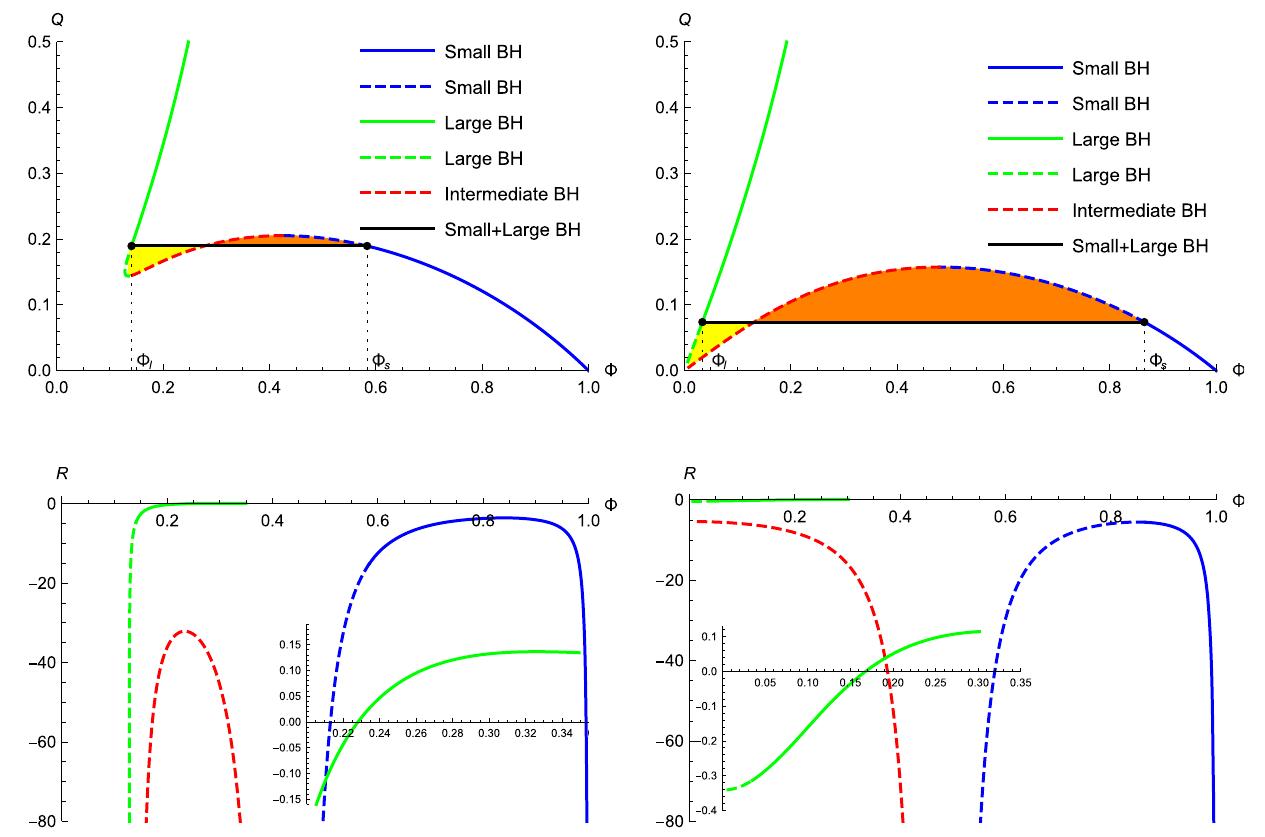
Fig. 8 The charge Q and the Ruppeiner invariant R as functions of the potential (cid:2) for a RN black hole in a cavity with a temperature T > T c , which possesses three solutions for some range of (cid:2) . The black lines denote the coexisting lines of Large BH and Small BH, and (cid:2) s /(cid:2) l denotes the potential of the saturated Small/Large BH. The blue/green